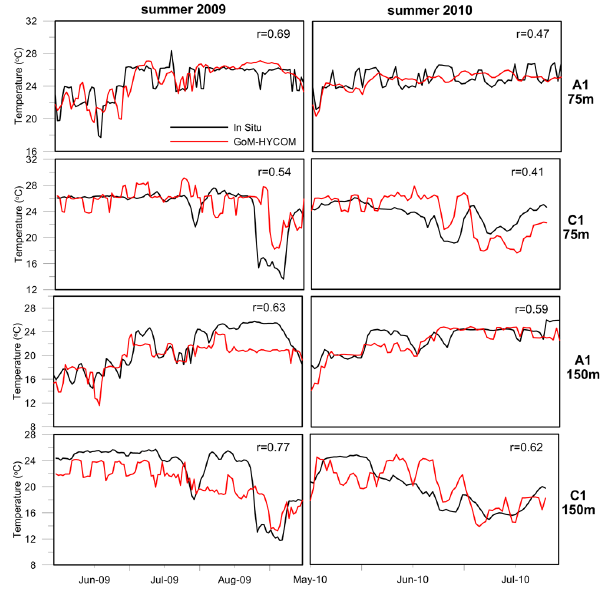
Figure 2. Daily GoM-HYCOM (red) and in situ (black) temper- ature time series for the summers of 2009 (left) and 2010 (right) at 75m (top panels) and 150m (bottom panels), at the A1 and C1 moorings (single model node closest to mooring position used). The correlation coefficients between the two time series ( r ) are also pre- sented for each